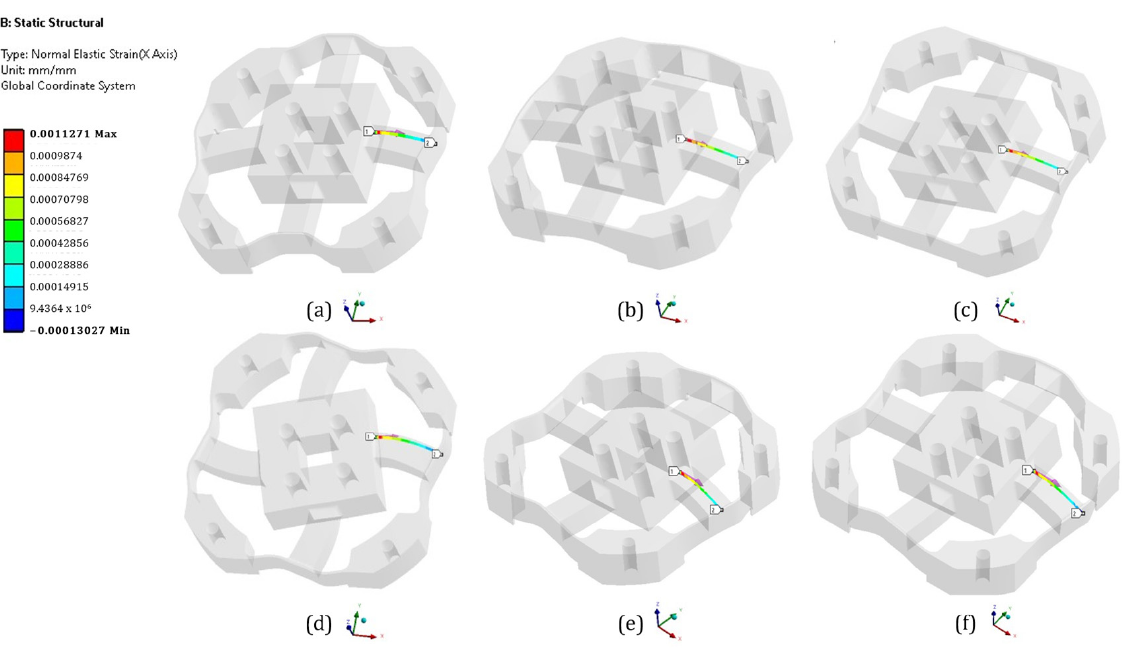
Figure 2. Normal strain ( X -axis) analysis in the middle line based on acting force ( a ) F Y loading on middle side line, ( b ) F Z loading middle top line, ( c ) M Y loading on middle top line, ( d ) M Z loading on middle side line, ( e ) Multiple loading on middle top line, and ( f ) multiple loading on middle side line.